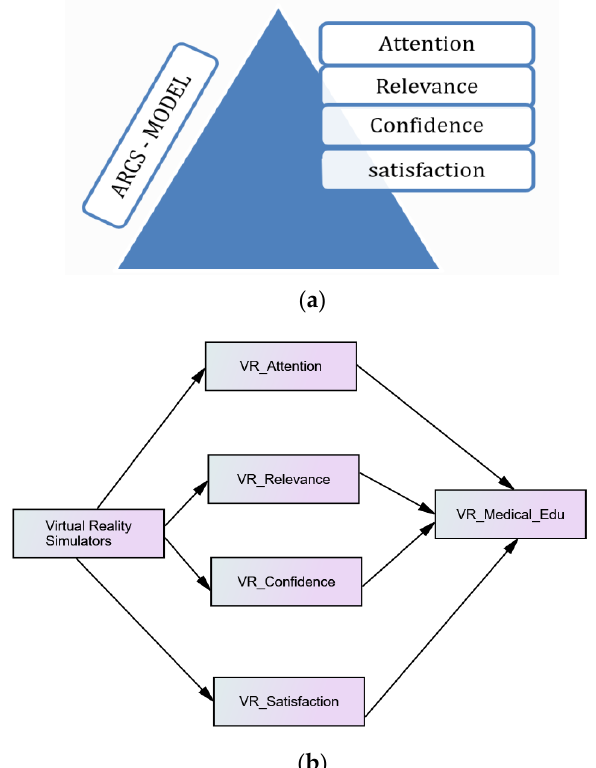
Figure 3. ( a ) ARCS model, ( b ). V.R. relevance and VR Simulators;